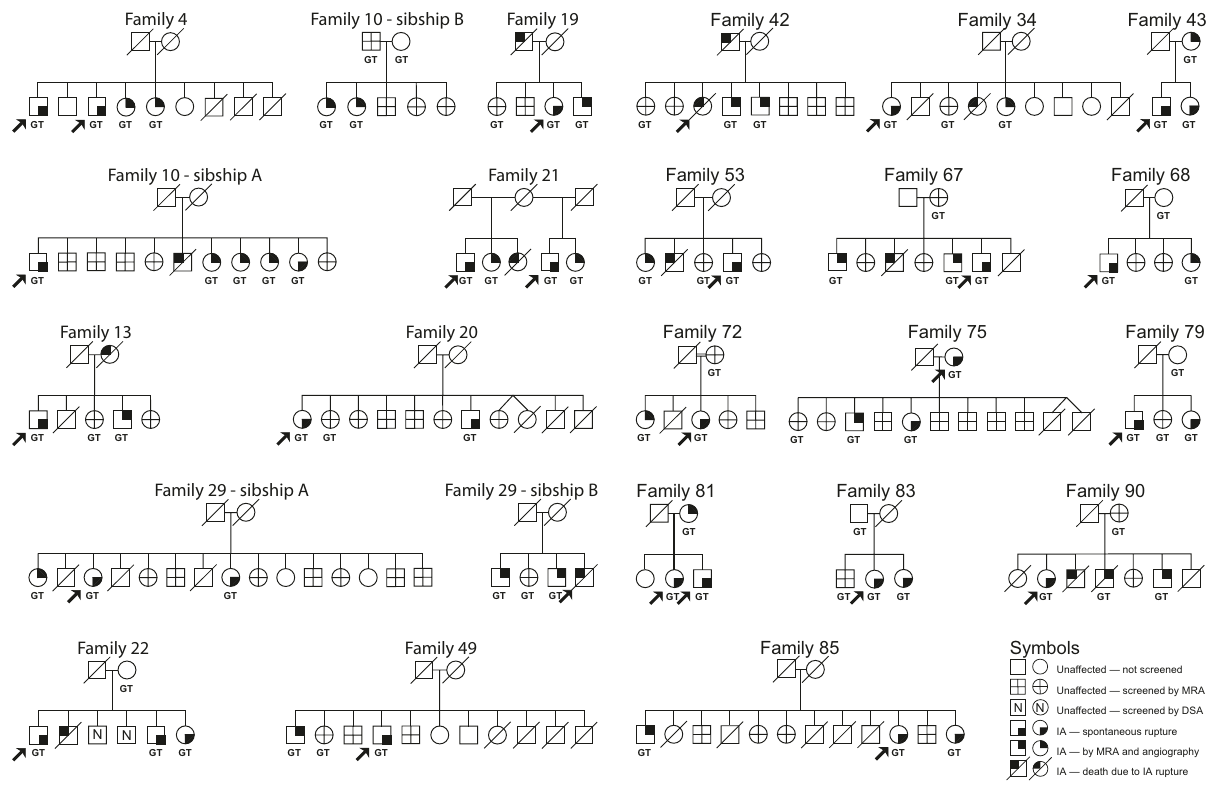
Figure 1 FIA Pedigrees. The genome scan was performed with the 48 of 49 affected sibling pairs from the 24 sibships since one of the pairs in family 21 was determined to be a non-sib pair. GT indicates that DNA from the corresponding individual was geno- typed. Symbols are defined in the figure: DSA denotes digital subtractive angiography; MRA denotes magnetic resonance angi-